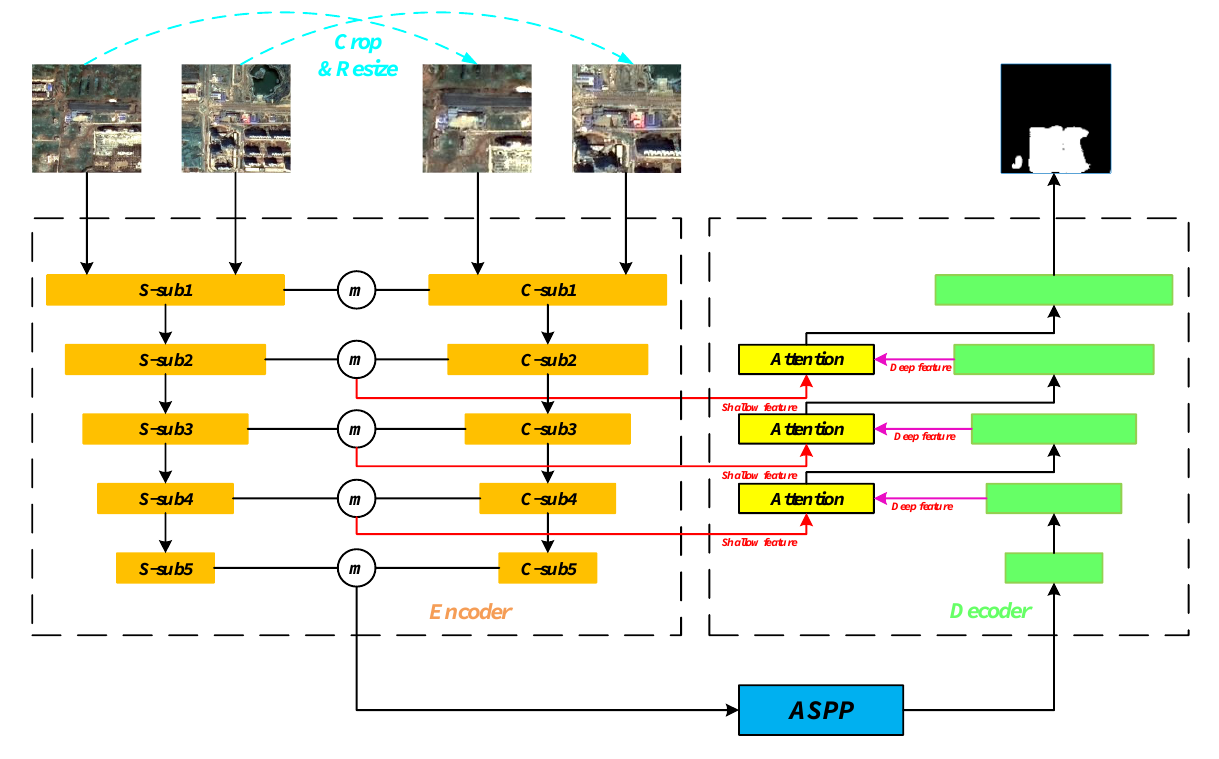
Figure 6. UNET-CD architecture.